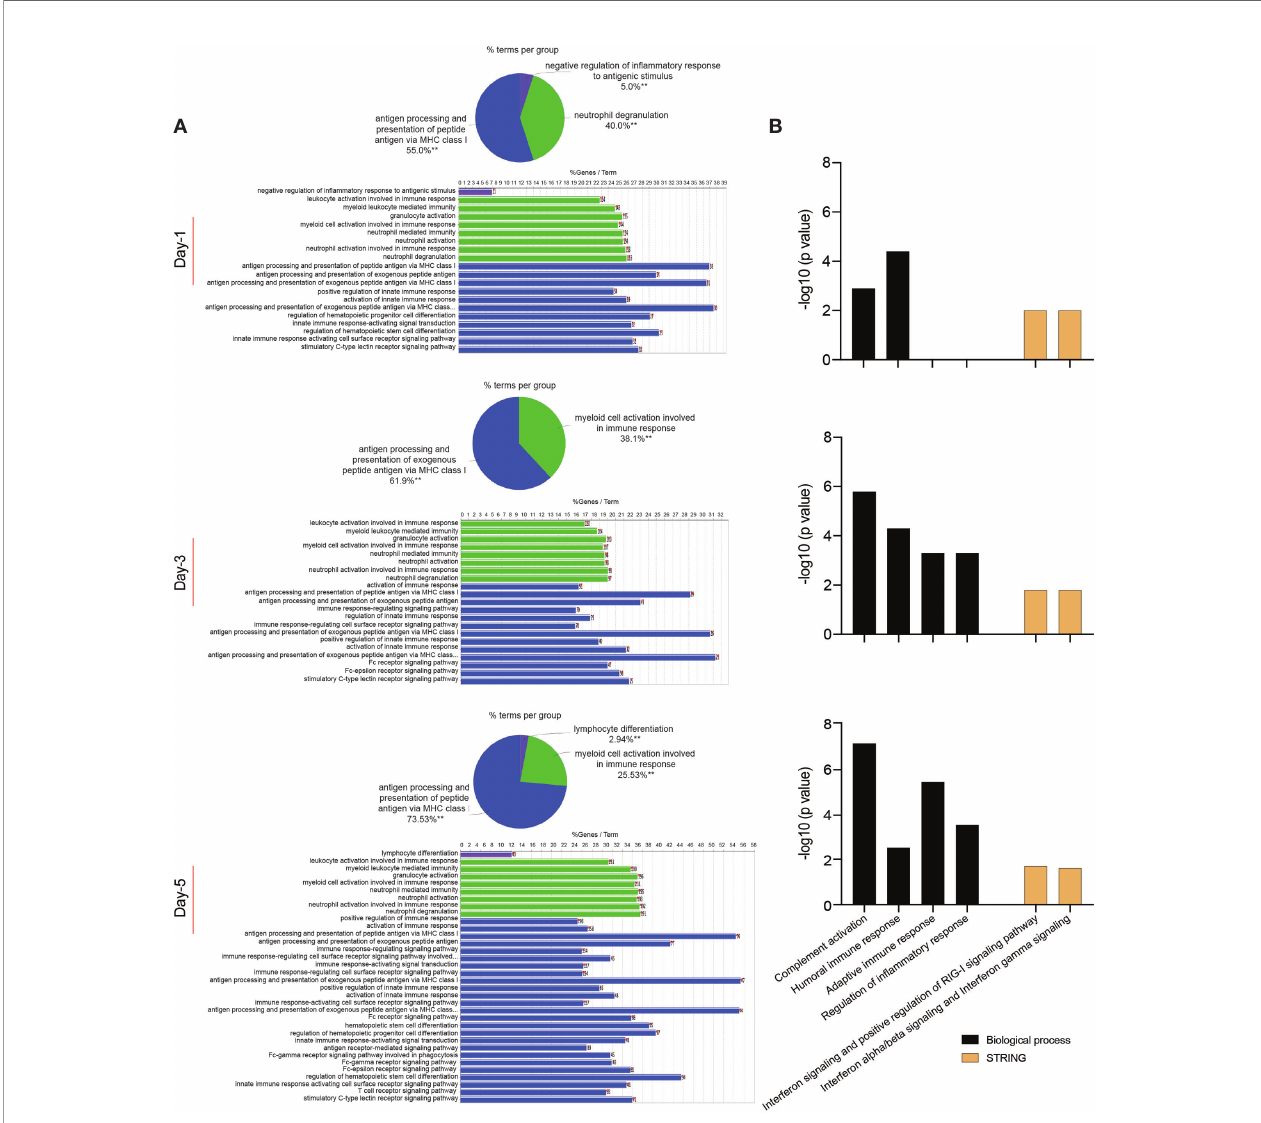
FIGURE 4 | Proteomic pro fi le of SARS-CoV-2-challenged MDMs. (A) Gene enrichment analysis was performed using Cytoscape in conjunction with the plug-in ClueGO at different times after viral exposure. Pie charts representing the distribution of identi fi ed differentially expressed proteins according to observed immune processes and bar charts demonstrating the speci fi c processes that correspond to their classi fi cation. The same color key used in the pie charts is applied in the bar charts. (B) Functional and pathway enrichment analyses of proteomic dataset were performed using GO annotation, KEGG, Reactome GSEA, and STRING analyses at different time points post-infection. Different immune-related biological processes and PPI networks affected in SARS-CoV-2-challenged MDMs were plotted as a bar chart compared to mock-challenged